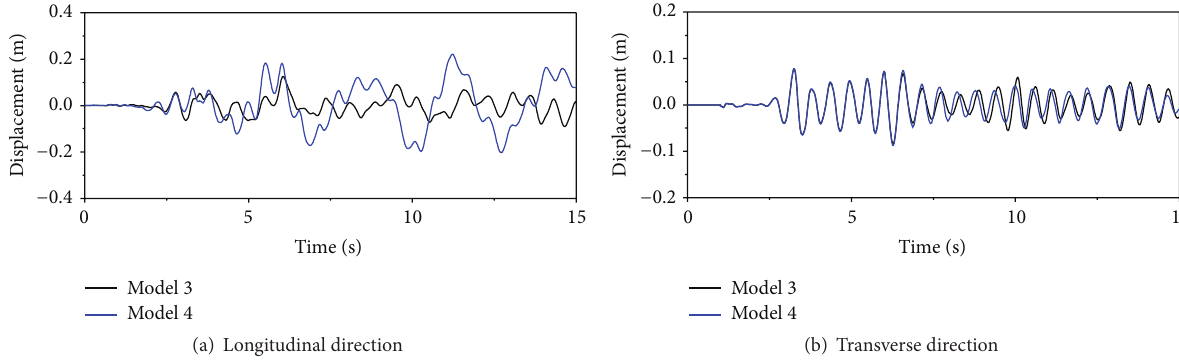
Table 5: Comparison of the maximum tension forces of the transmission lines of the two models of the tension